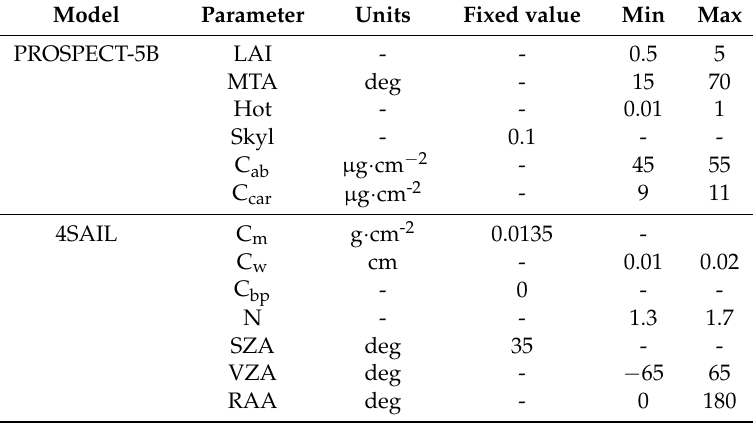
Table 3. Overview of PRO4SAIL-5B parameter ranges. Skyl: the fraction of diffuse incoming solar radiation; Hot: hot spot size parameter; C ab : leaf chlorophyll a and b content; C car : leaf carotenoid content; C m : leaf dry matter content; C w : equivalent water thickness; C bp : leaf brown pigment content; VZA: view zenith angle (VZA); RAA: relative azimuth